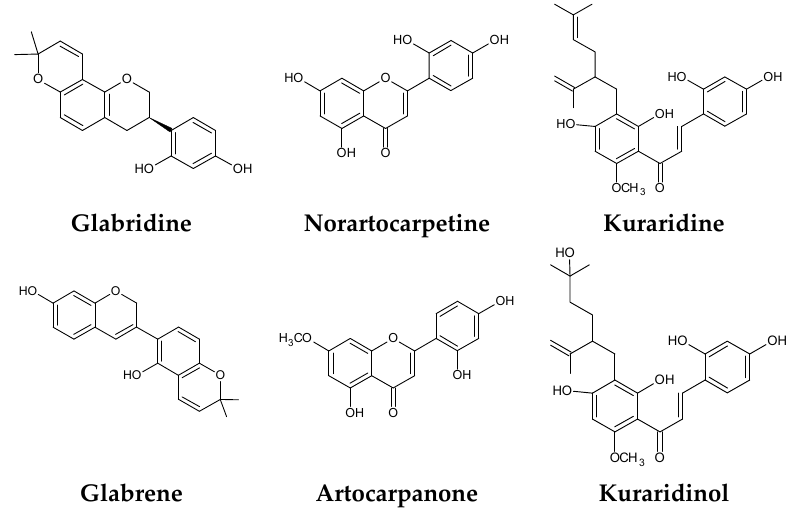
Figure 2. Some natural whitening agents.